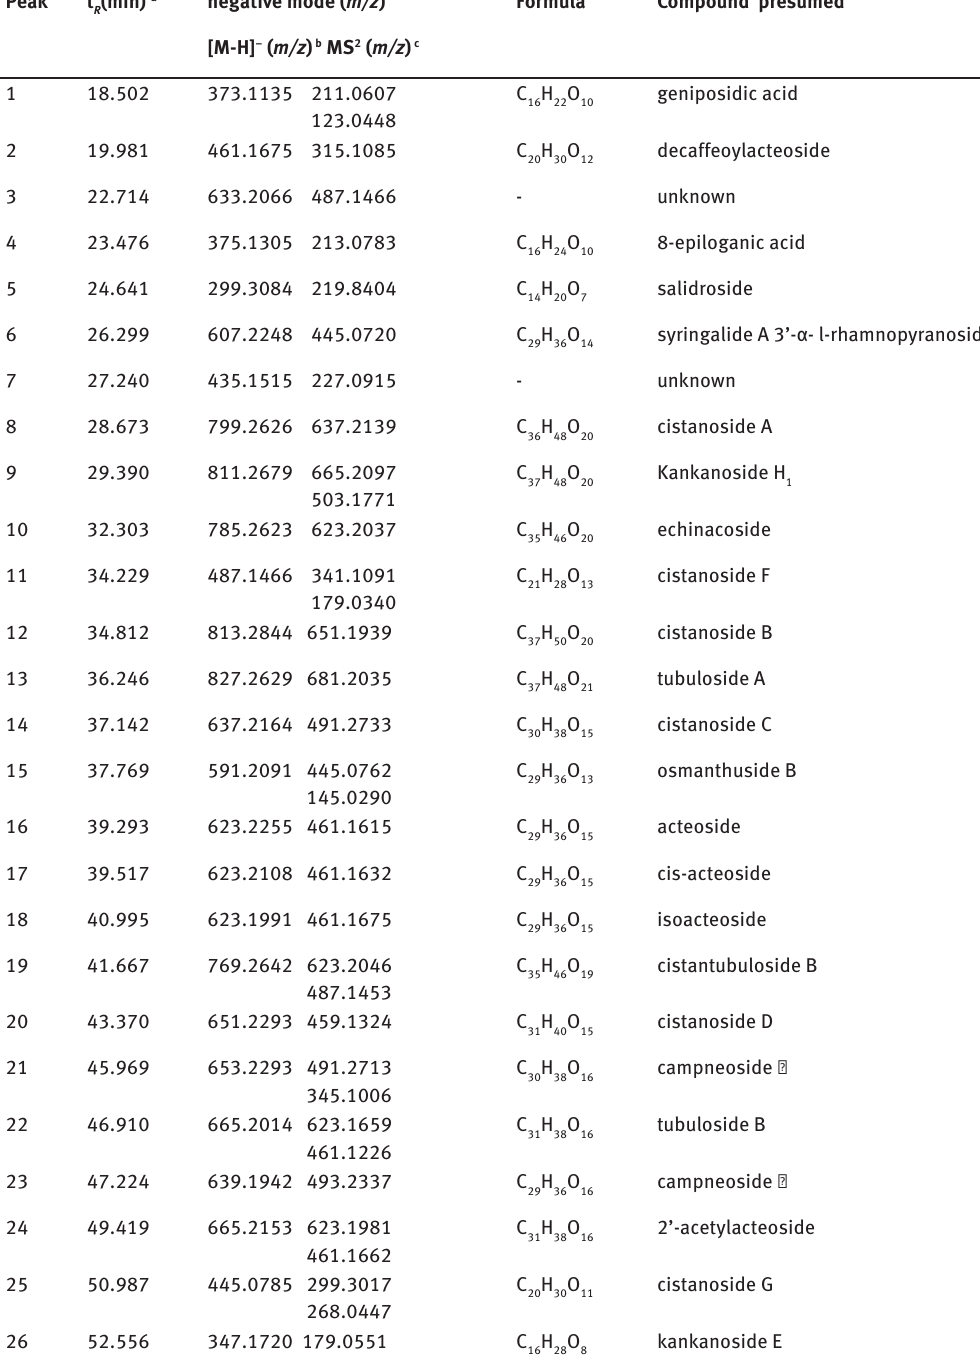
Table 1: Identification of chemical composition of the peaks.